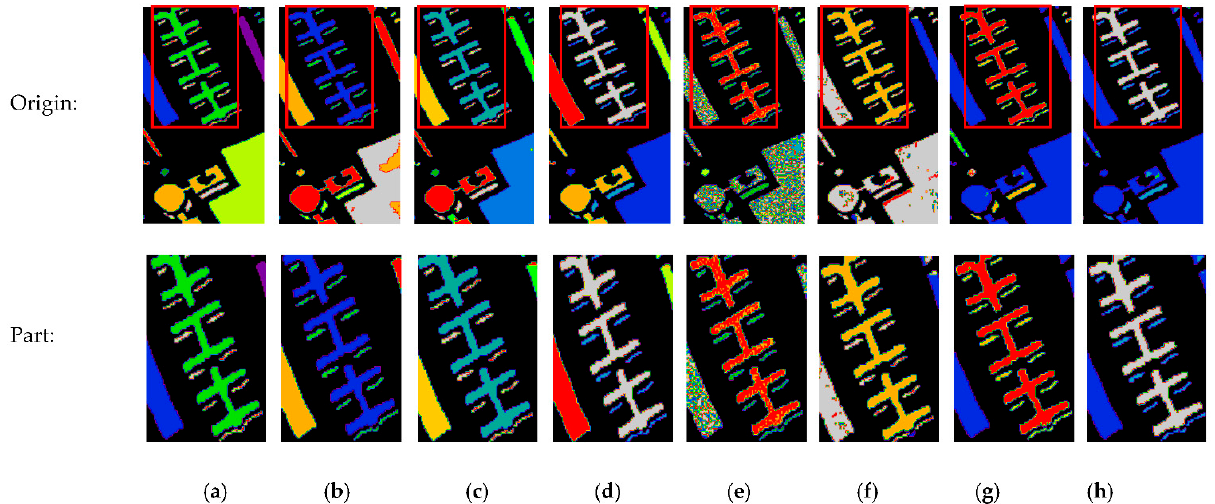
Figure 4. Clustering results obtained using different methods on the Pavia University data set. ( a )